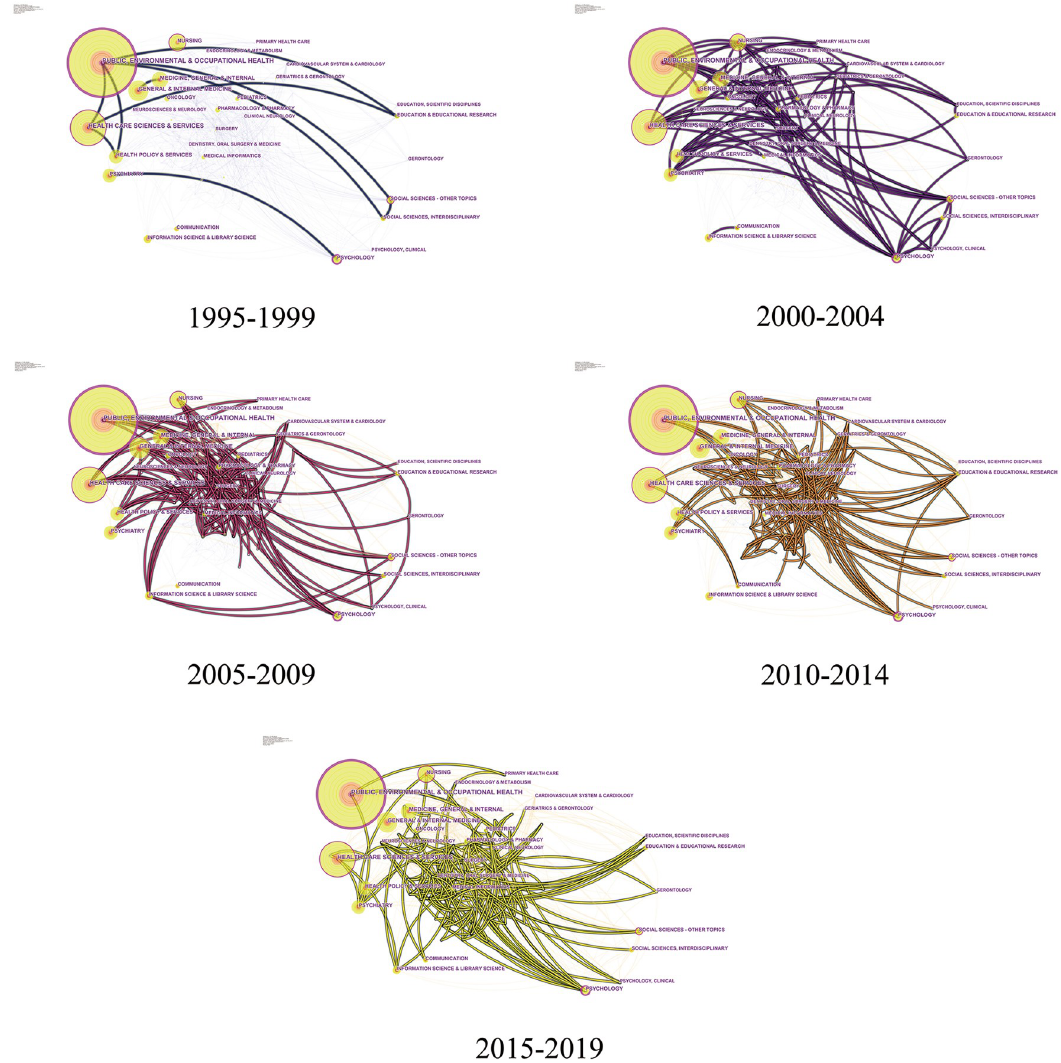
Fig 6. Category collaboration network of health literacy. Each node indicates a category, and the larger the node, the more papers were published. Each edge indicates a collaborative relationship between two